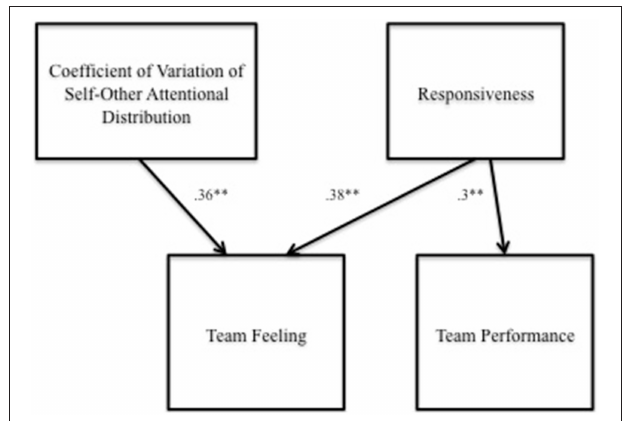
FIGURE 4 | Path model of attentive action in SMT coordination and performance. Statistics are standardized coefficients based on bootstrap samples (5000 replications). ** p <